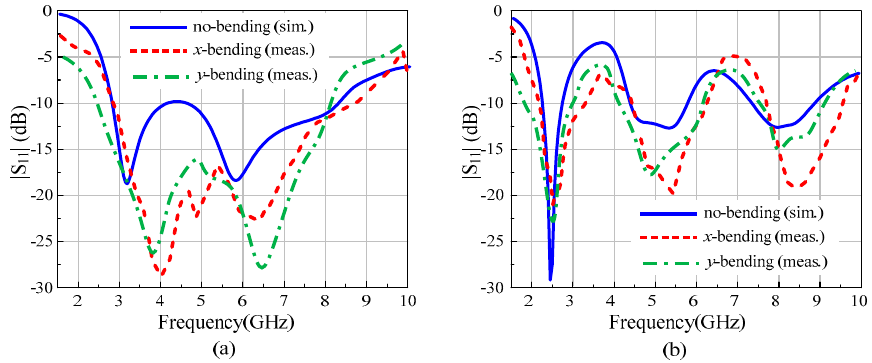
Figure 9. Conformability analysis of the proposed antenna: ( a ) diode ON, ( b ) diode OFF.